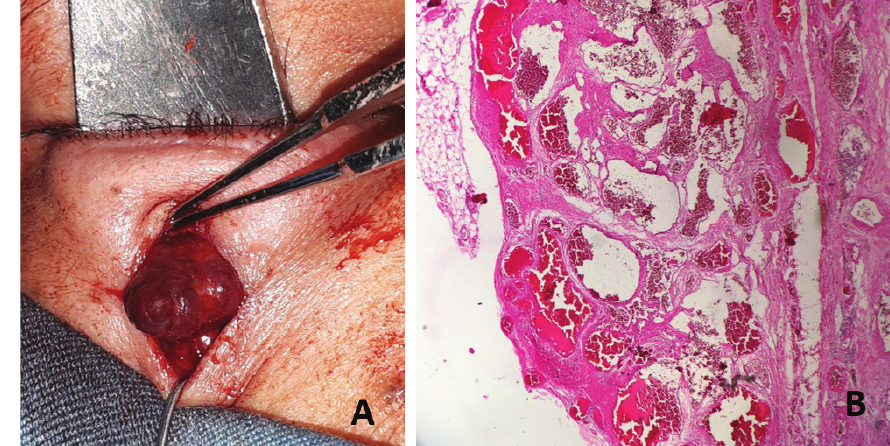
Figure 3. (A) Intraoperative view of the mass shows a dark-red encapsulated mass which is seen bilobed in the anterior view. (B) Microscopic pathology shows dilated thick wall spaces with a single layer of endothelium loaded with blood cells and thrombosis and a well-defined capsule typical of orbital cavernous hemangioma (Hematoxylin and Eosin, magnification ×